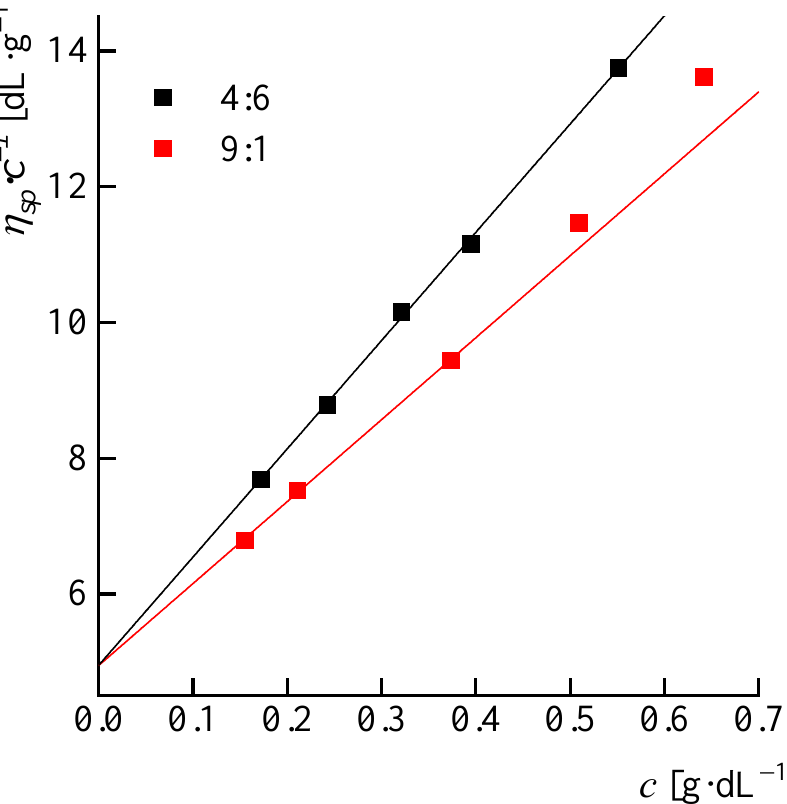
Figure A3. Dependences of the reduced viscosity on the concentration for ABPBI solutions with different DMSO:MeOH ratios in the DMSO:MeOH:KOH complex solvent at 25 °C.